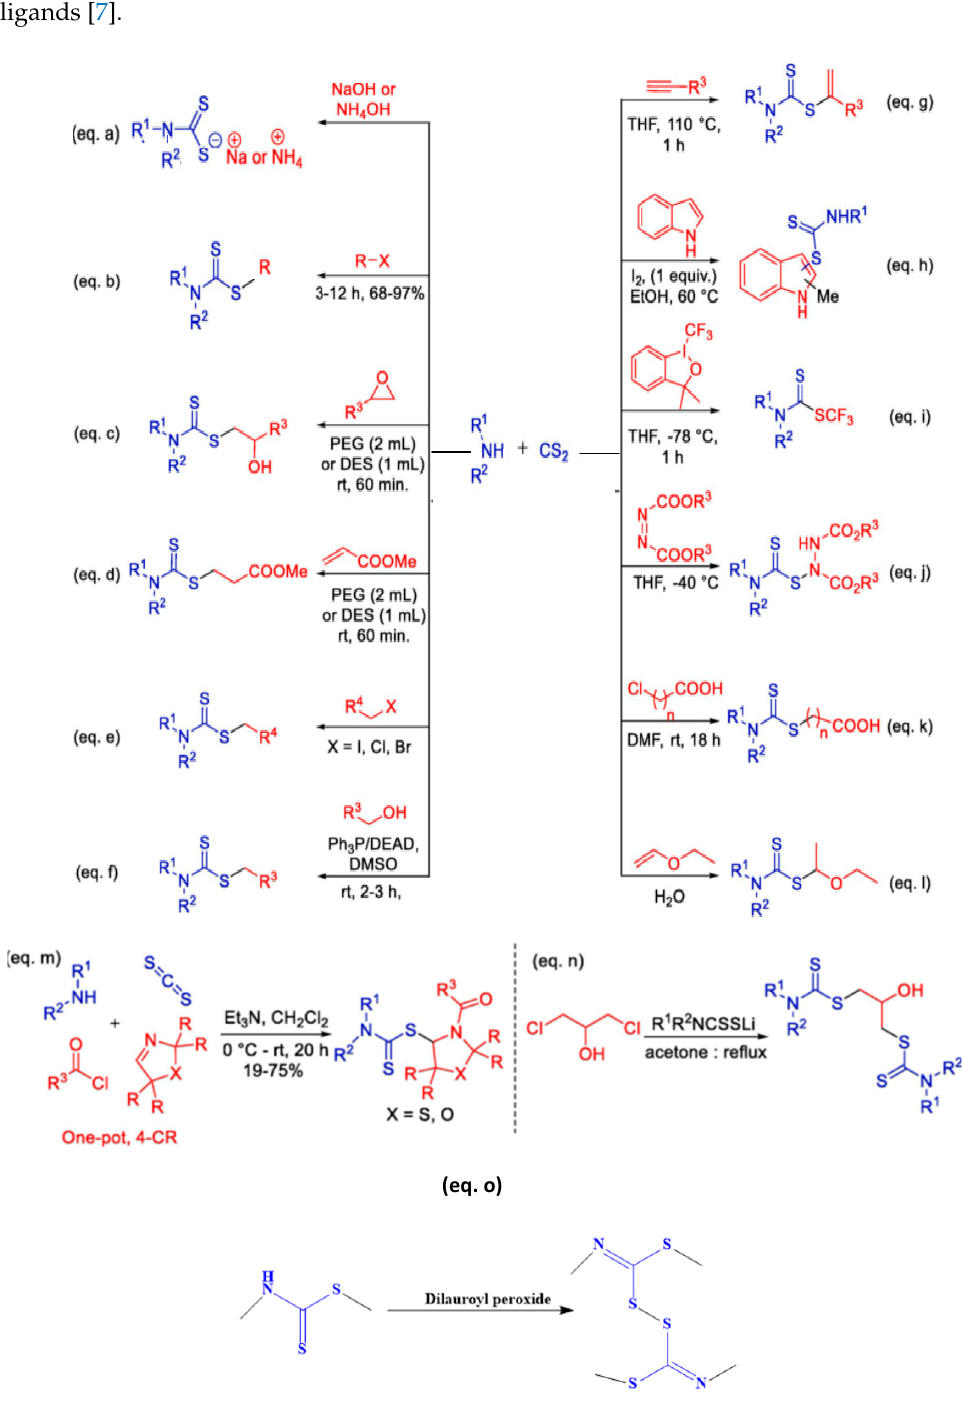
Figure 1. Various routes for the synthesis of dithiocarbamates. Adapted from [3]. Copyright (2020), with permission from Elsevier.